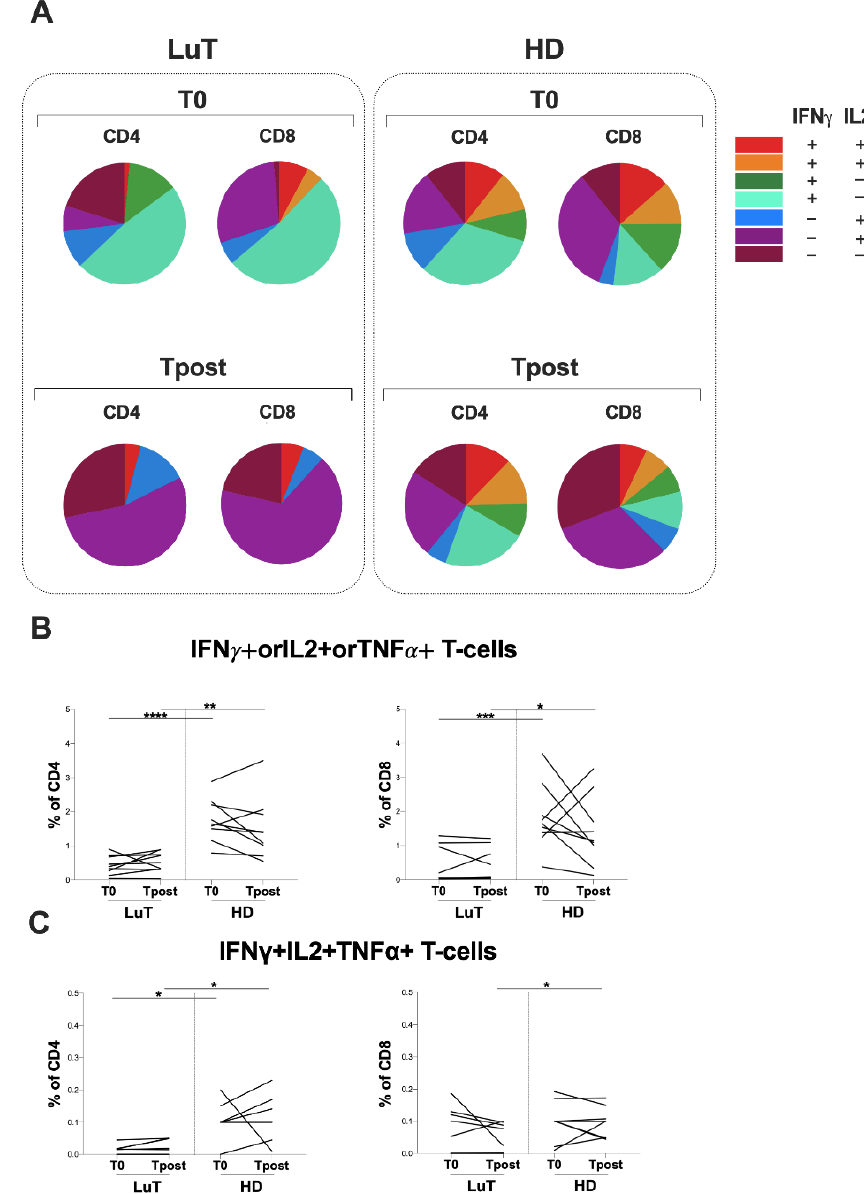
Figure 3. ( A ) Percentages of CD4+ and CD8+ T-cells producing all combinations of IFN γ , IL2, and TNF α by CD4+ and CD8+ T-cells in the LuT and HD groups at both time-points. The fractions of pie charts representing the different combinations of IFN γ , IL2, and TNF α . ( B ) The IFN γ +orIL2+orTNF α +CD4+ and CD8+ T-cell response was evaluated in the LuT and HD groups at two time-points: at T0 and Tpost. Longitudinal evaluation in the LuT group was performed using the Wilcoxon test. Differences between LuT and HD were evaluated using the nonparametric Mann–Whitney test. ( C ) The IFN γ +IL2+TNF α + CD4+ and CD8+ T-cell response was evaluated in the LuT and HD groups at two time-points: at T0 and at Tpost. Longitudinal evaluation in the LuT group was performed using the Wilcoxon test. The differences between LuT and HD were evaluated using the nonparametric Mann–Whitney test. T0: before the third dose of vaccine; Tpost: two months after the third dose; LuT: lung transplants; HD: healthy donors; ****: p < 0.0001; ***: 0.0001 < p < 0.001; **: 0.001 < p < 0.01; * 0.05 < p <